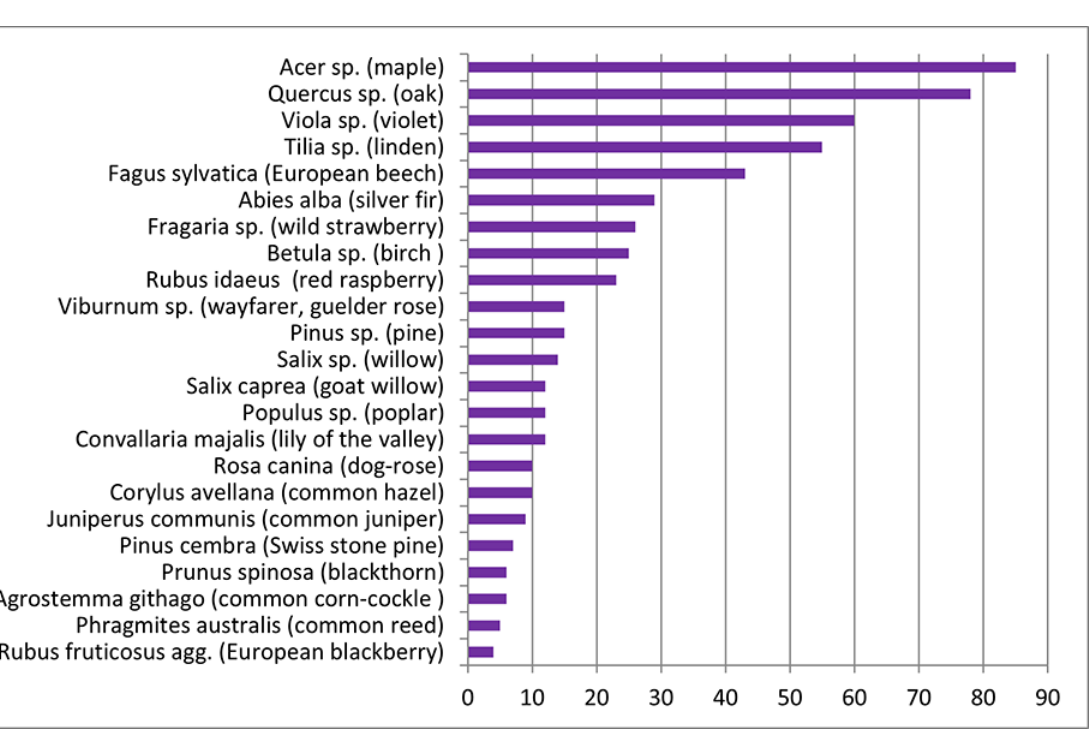
ActaSocietatisBotanicorumPoloniae / 2022 / Volume 91 / Article 9116 Publisher: Polish Botanical